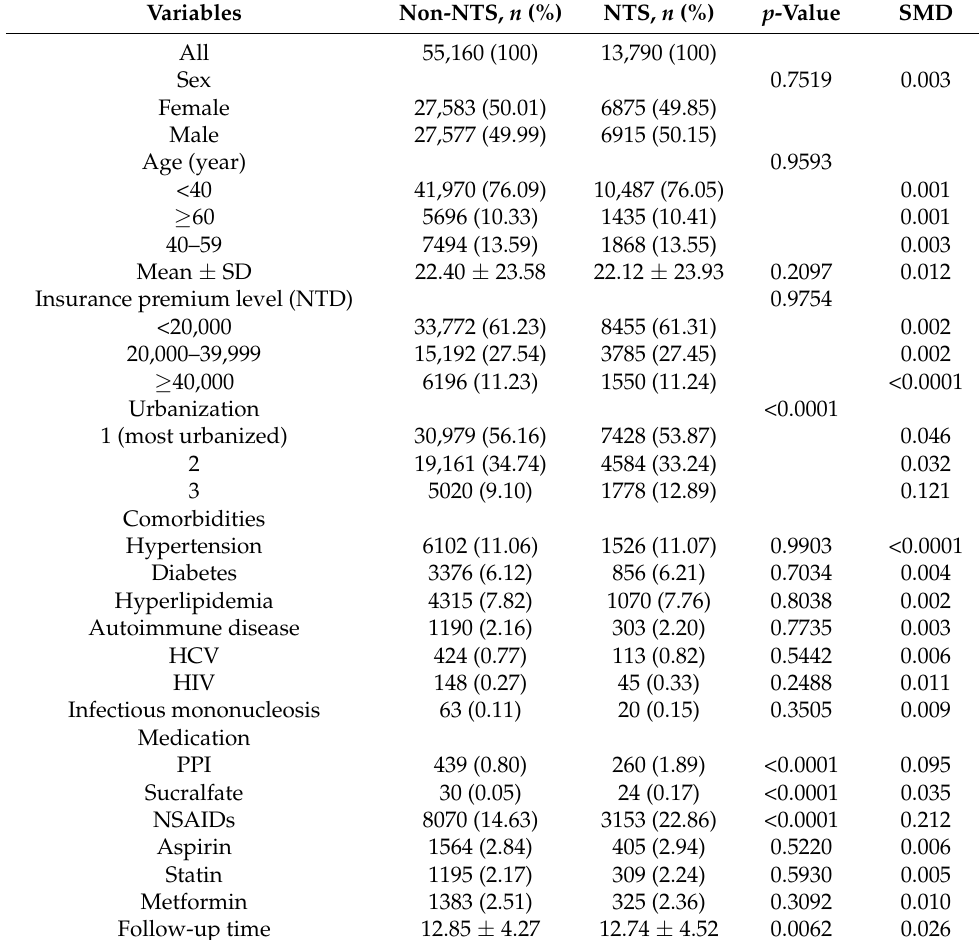
Table 1. Characteristics of patients with and without NTS in